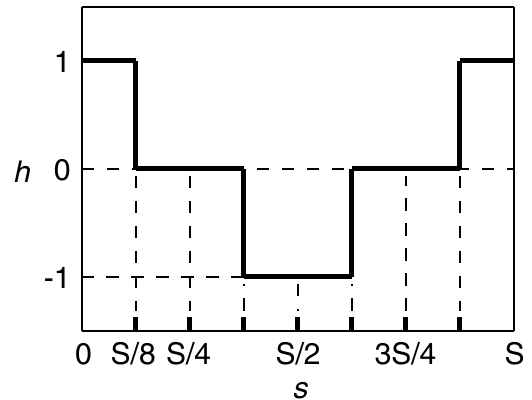
FIG. 1. Alternating periodic step function h (cid:5) s (cid:6) (cid:2) h (cid:5) s (cid:7) S (cid:6) of beam transport channel by FODO